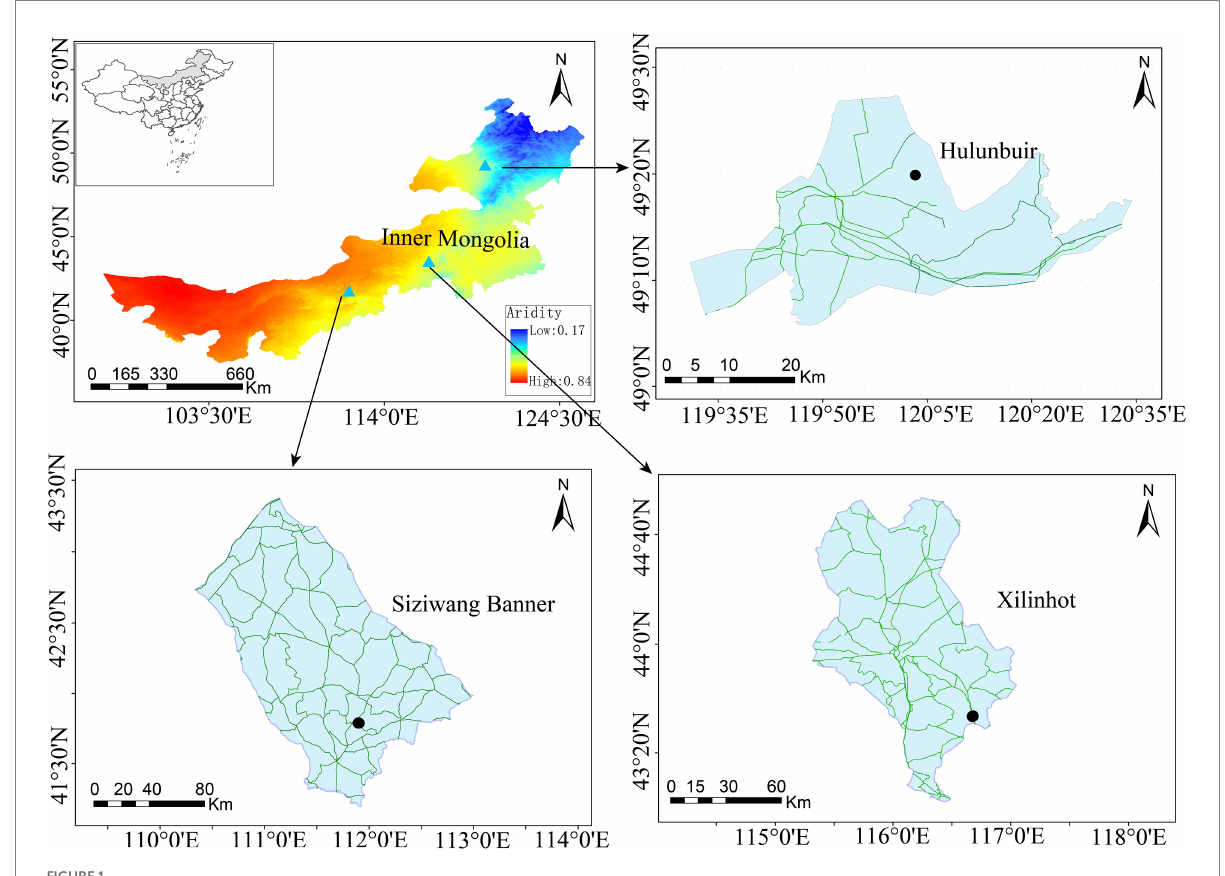
FIGURE 1 Study areas and sampling sites (Aridity is presented as one minus the aridity